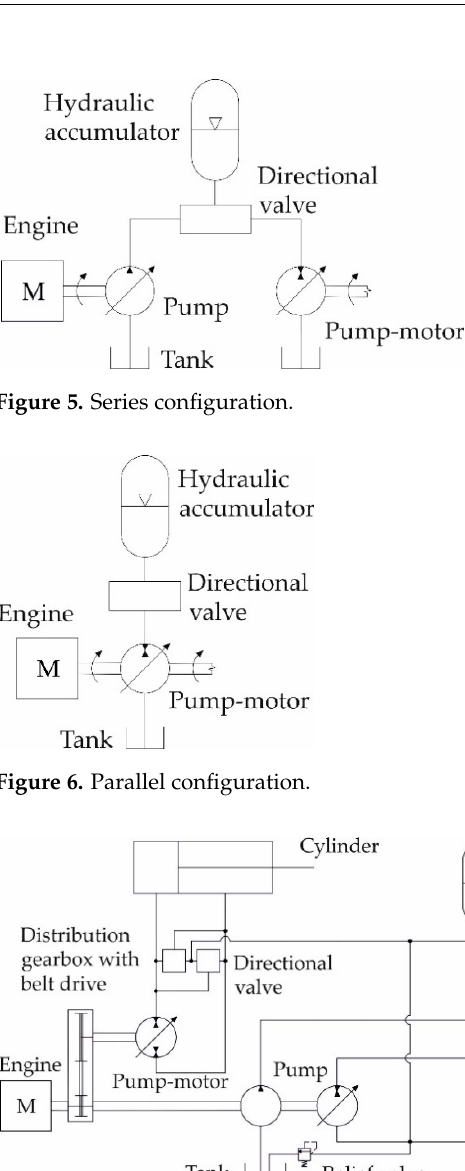
Figure 7. Power split (series–parallel) configuration.